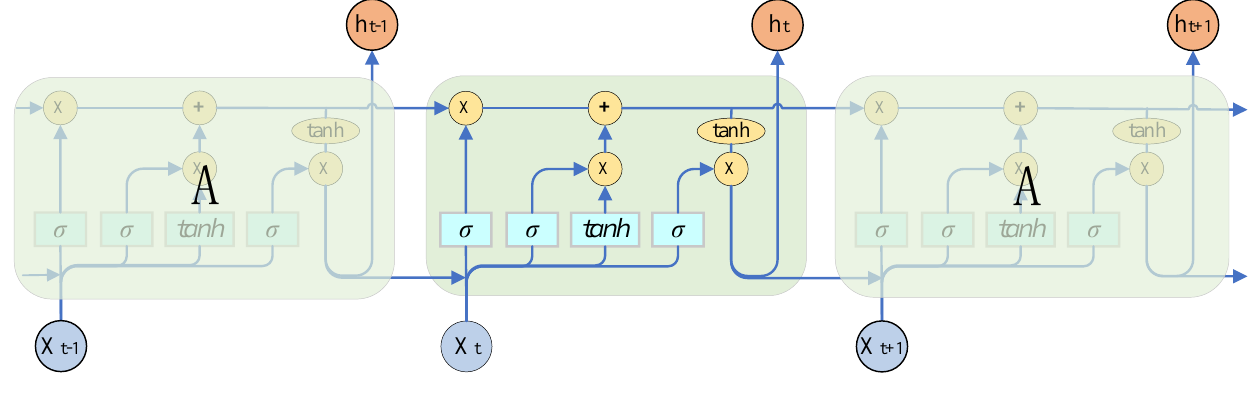
Figure 2. Structural diagram of the